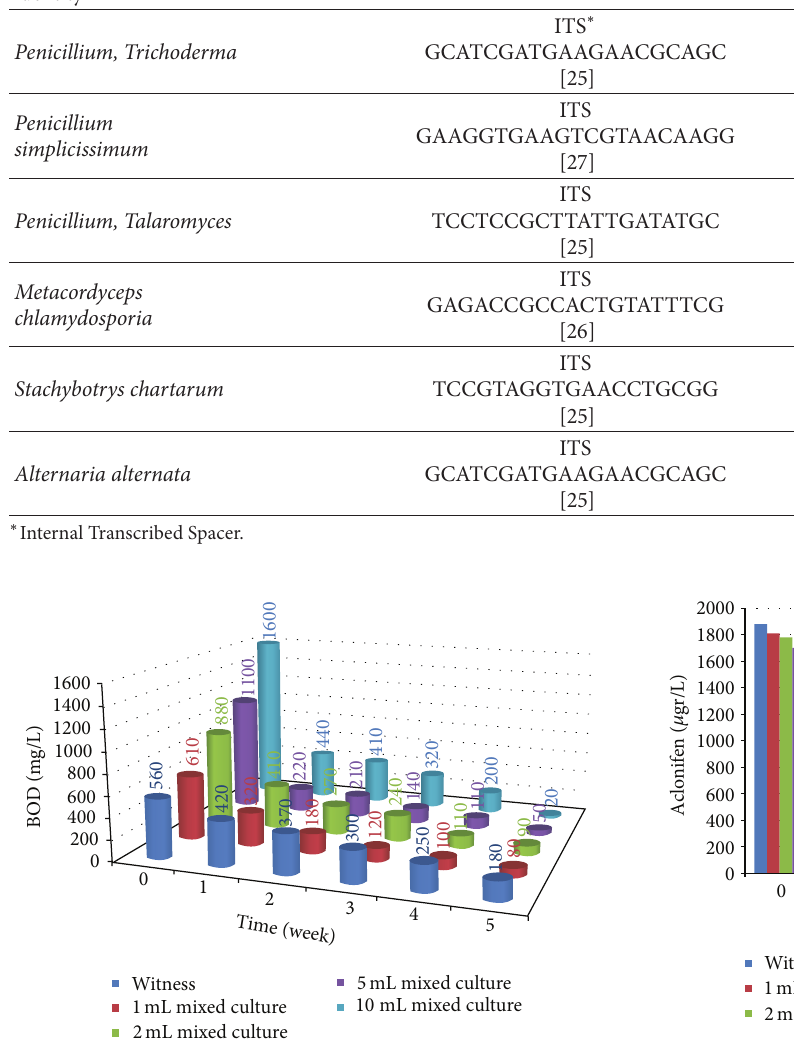
Figure 4: Biochemical oxygen demand results in the filtrate.